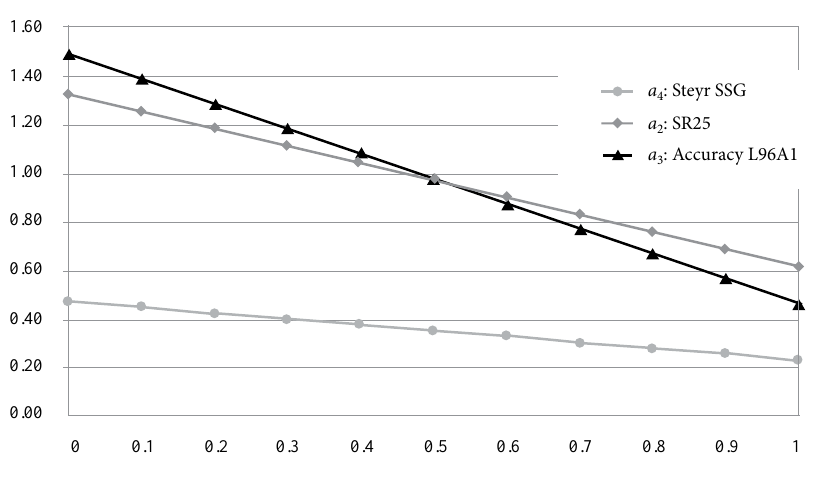
Fig. 10. Effect of changing β (